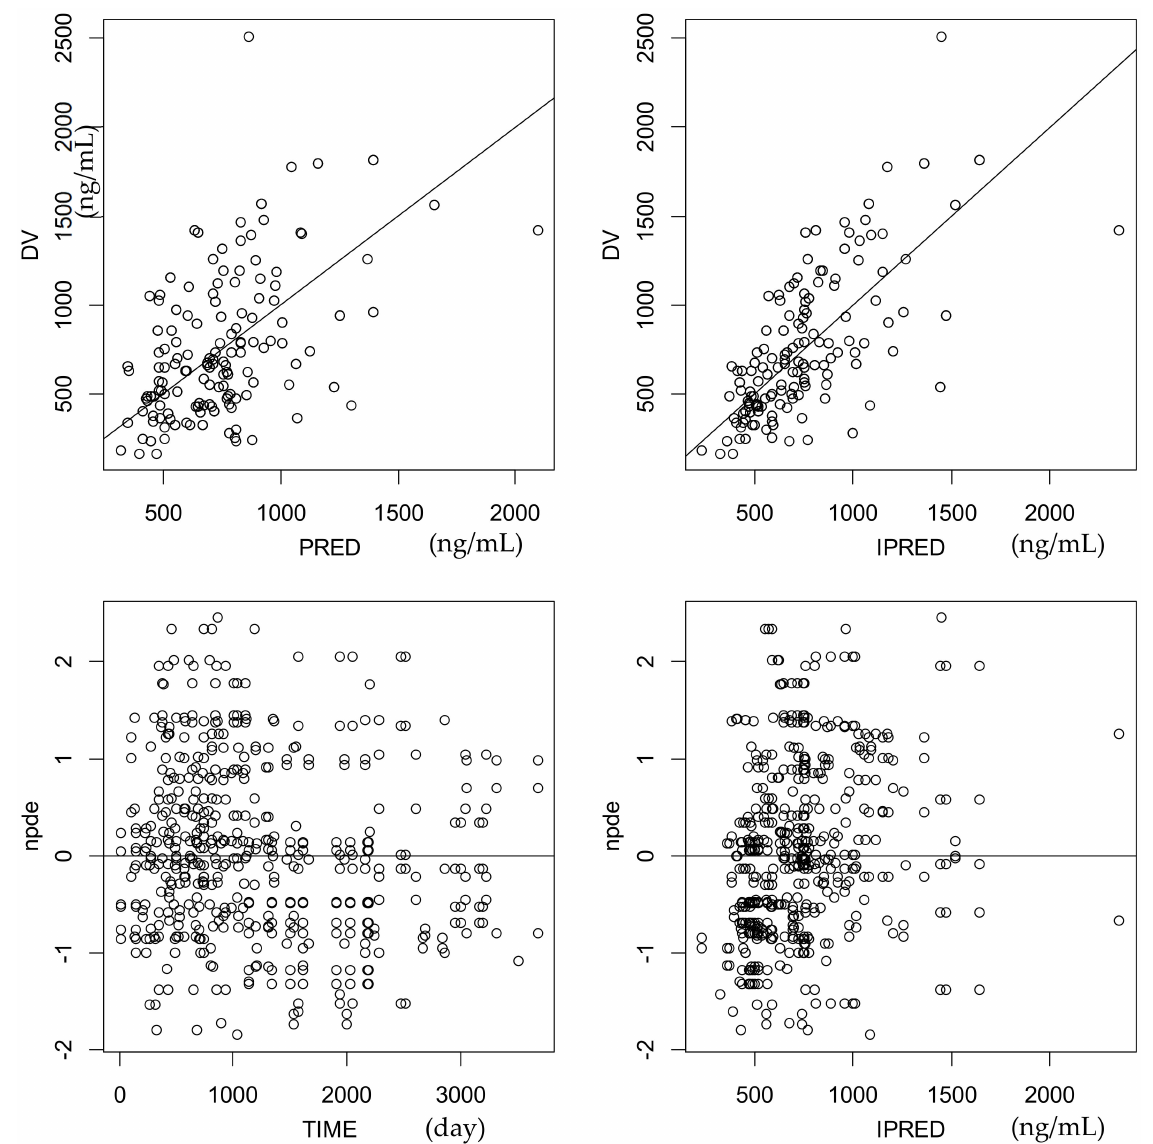
Figure 1. Goodness-of-fit plots showing the observed HCQ concentrations (DV) versus predicted (PRED) and individual predicted concentrations (IPRED) and normalized prediction distribution errors (npde) versus time and IPRED for the final